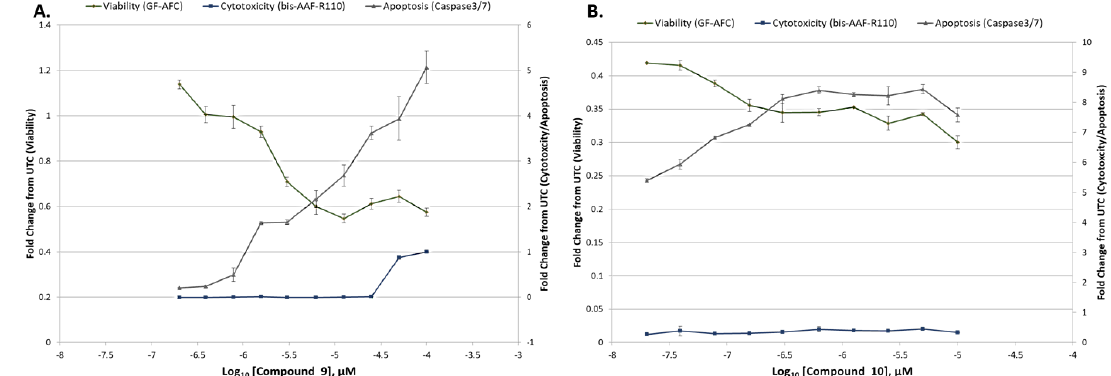
Figure 4. The ApoTox-Glo triplex assay against SUP-B15 to determine viable cells (using GF-AFC as fluorescent readout), apoptotic cells (caspase 3 / 7Glo as luminescent readout) or cytotoxicity by membrane integrity (bis-AAF-RF110 as fluorescent readout) upon compound treatment for 36 h. A. compound 9 (0.2–100 µ M). B. compound 10 (0.02–10 µ M). Graphs show decrease in cell viability, while